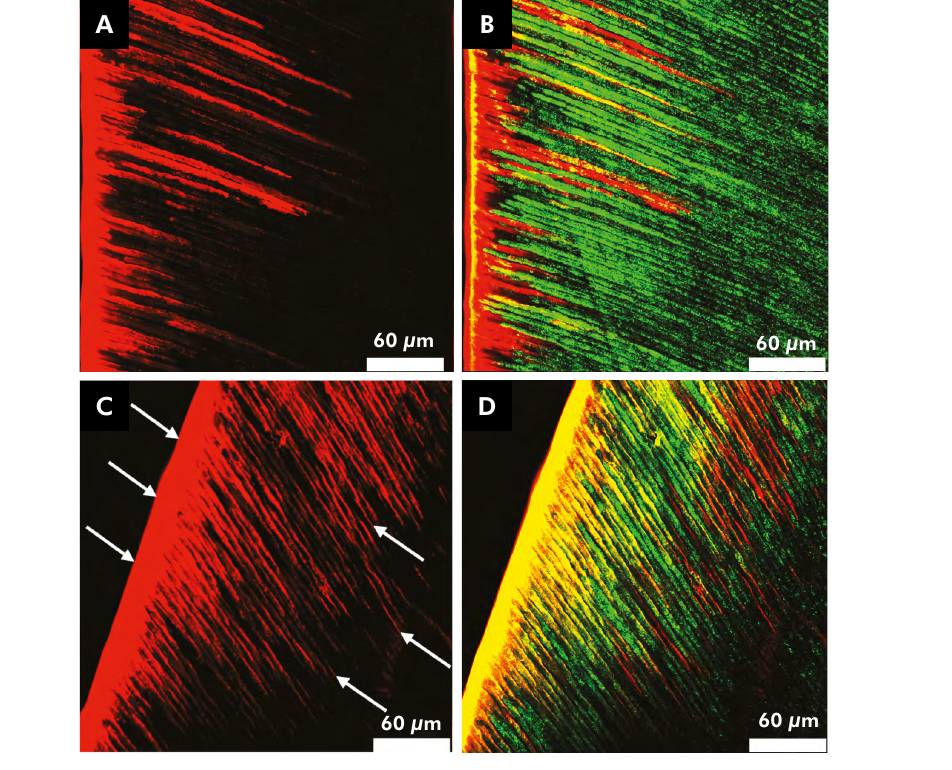
Figure 3. TEGDMA-based group showed deep infiltration into the lesion, regardless of the temperature (dual fluorescence mode). A, B. TEGDMA group at 25º C. C, D. TEGDMA group at 55º C, showing that the heated infiltrant presented more homogeneous infiltration than the resin at 25º C (white